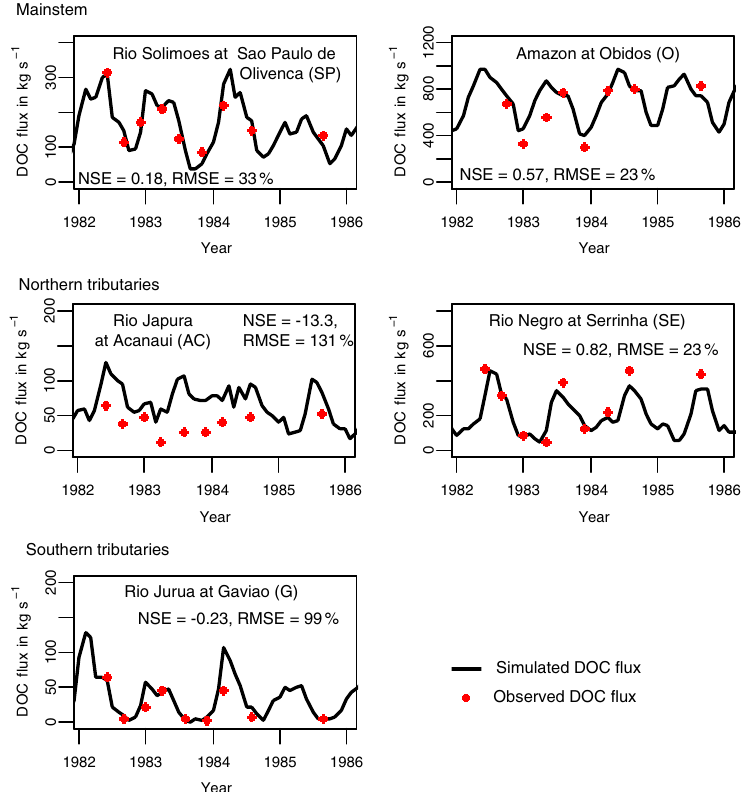
Figure 14. Simulated versus observed DOC fluxes in the Amazon main stem and its major tributaries. Observed data are taken from the CAMREX data set (Richey et al.,